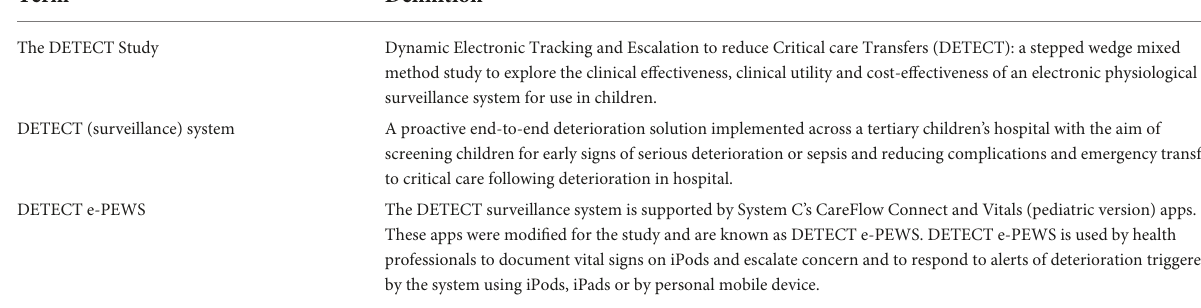
TABLE 1 Definitions of DETECT-related terms.